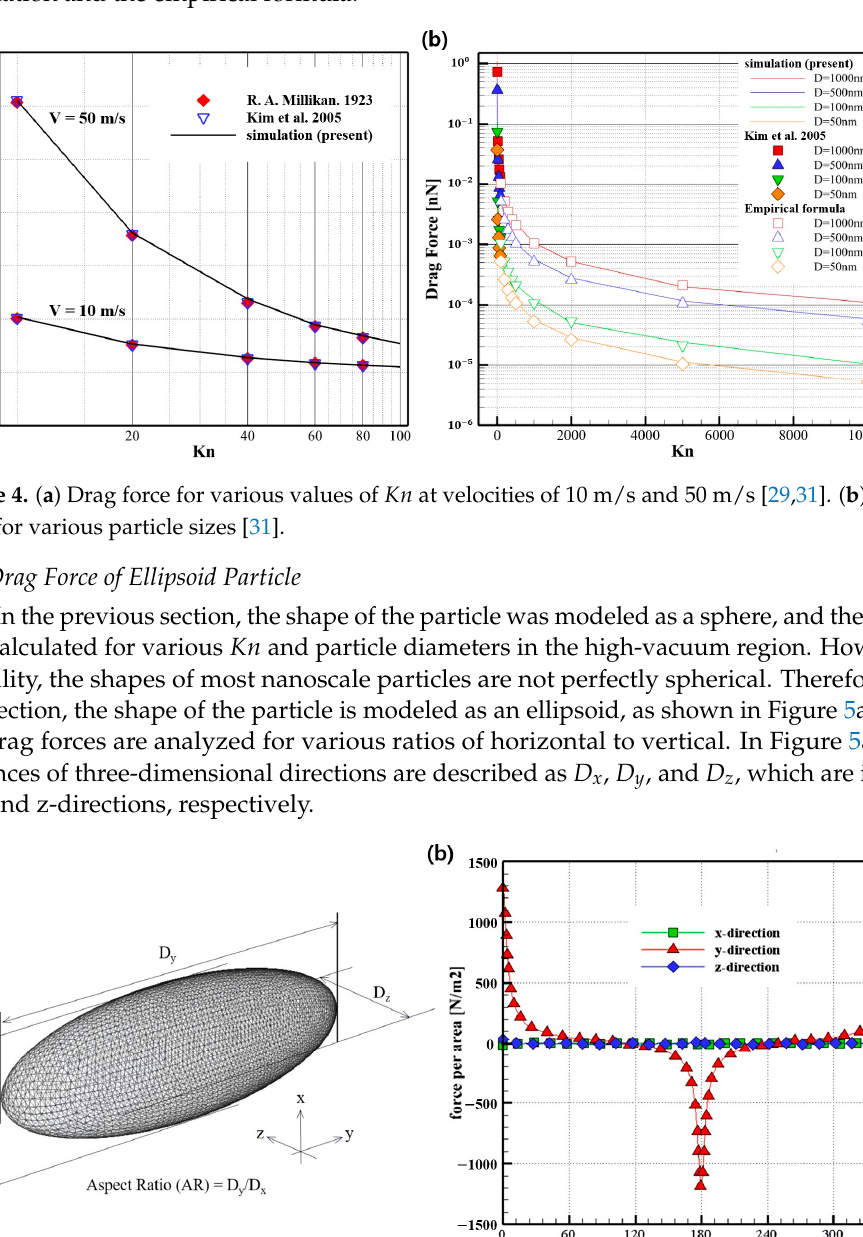
Figure 6. ( a ) Drag force for various aspect ratios ( 𝐷 (cid:3051) = 50 nm ). ( b ) Drag force for various aspect ratios ( 𝐷 (cid:3051) = 100 nm ). The trend of the drag force for the di ff erence between 𝐾𝑛 and AR with di ff erent di- ameters is similar. As 𝐾𝑛 increases, the drag force decreases, and as AR increases, the drag force increases under the same fl ow conditions. We calculated the ratio of increase in the drag force as the AR increases. Figure 7 shows the ratio of the drag force based on the sphere-shaped drag force with AR = 1 as AR increases when 𝐾𝑛 is the same. The drag force ratio can be expressed using the fol- lowing formula: 𝐹 (cid:3005) /𝐹 (cid:3005),(cid:3002)(cid:3019)(cid:2880)(cid:2869) .